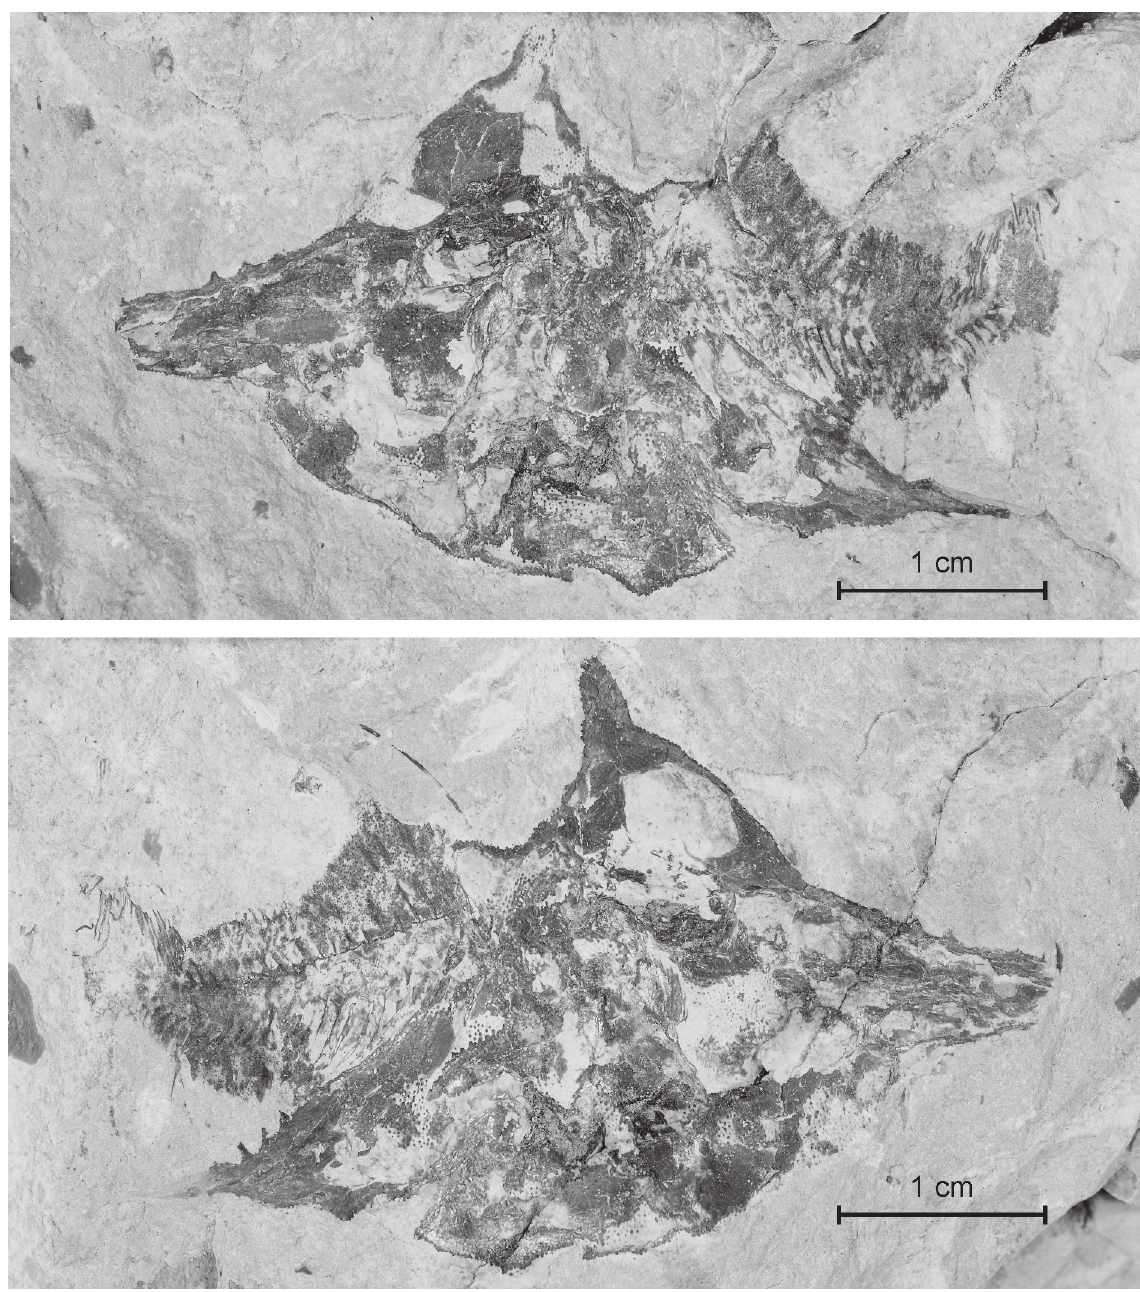
Fig. 15. Rostropycnodus gayeti gen. et sp. nov. Holotype CLC S-608a (above) and 608b